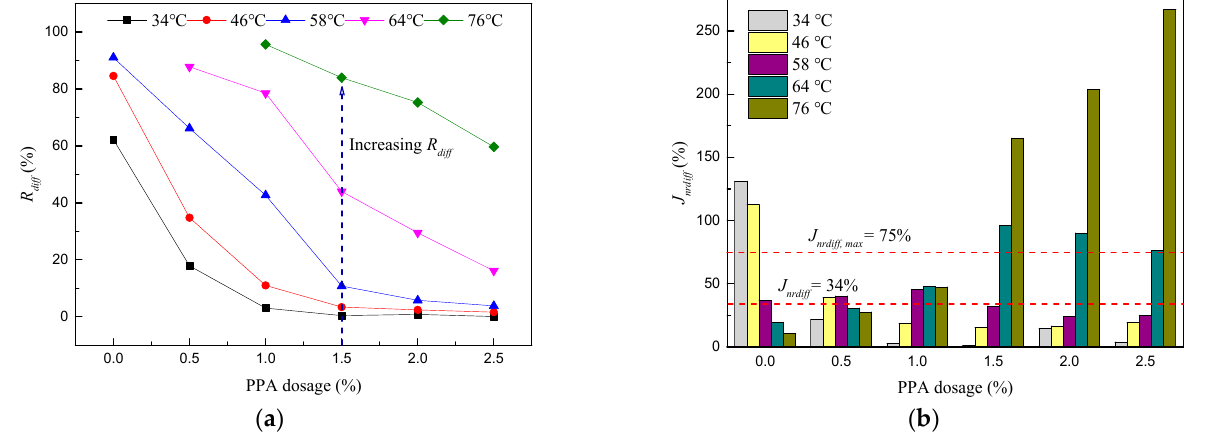
Figure 6. Percent difference in R and J nr between 0.1 kPa and 3.2 kPa ( a ) R dif f , ( b ) J nrdif f . Enlarge Figure 4d and plot recommended values of J nr ( 3.2 ) (see Table 2) in Figure 7 to determine the applicable tra ffi c levels for PPA-modi fi ed asphalt binders.